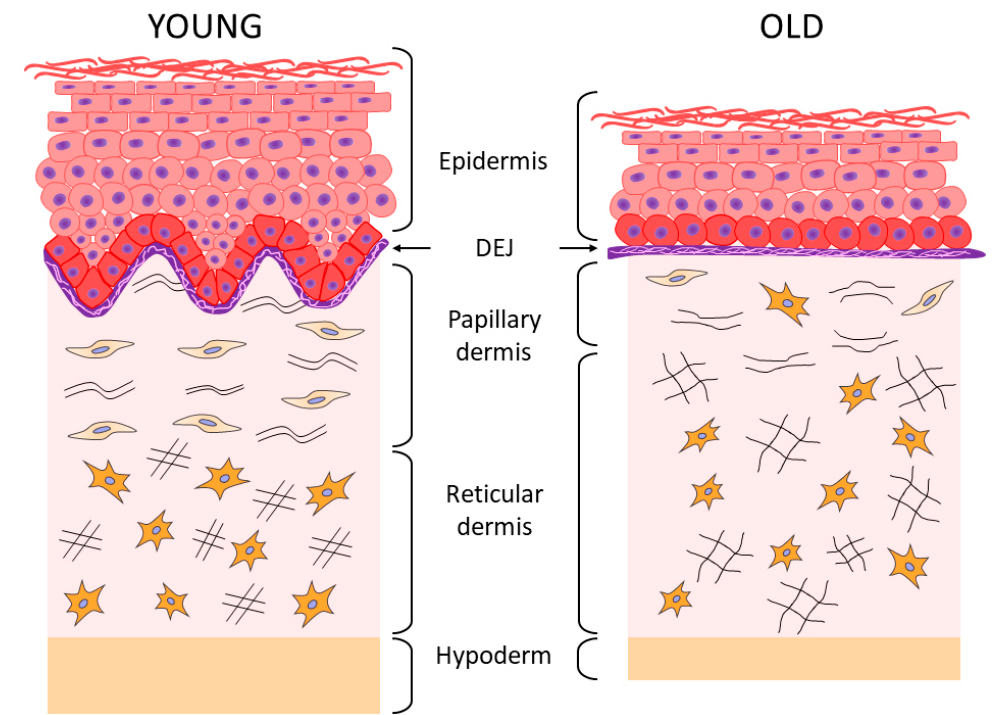
Figure 1. Schematic representation of skin